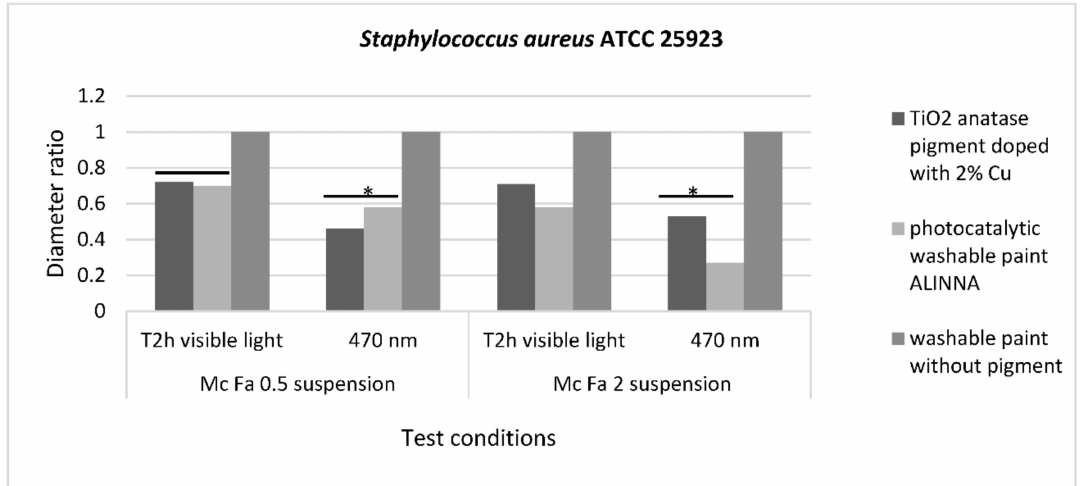
Figure 16. Graphic representation of inhibition zone diameters expressed as diameter ratio, obtained for S. aureus ATCC 25923 after incubation in two different conditions: visible light and blue light (470 nm). * 0.05 ≥ p (T ≤ t) > 0.001 is significant evidence of inhibitory effect manifested by 2% copper-doped TiO 2 pigment on bacterial growth and